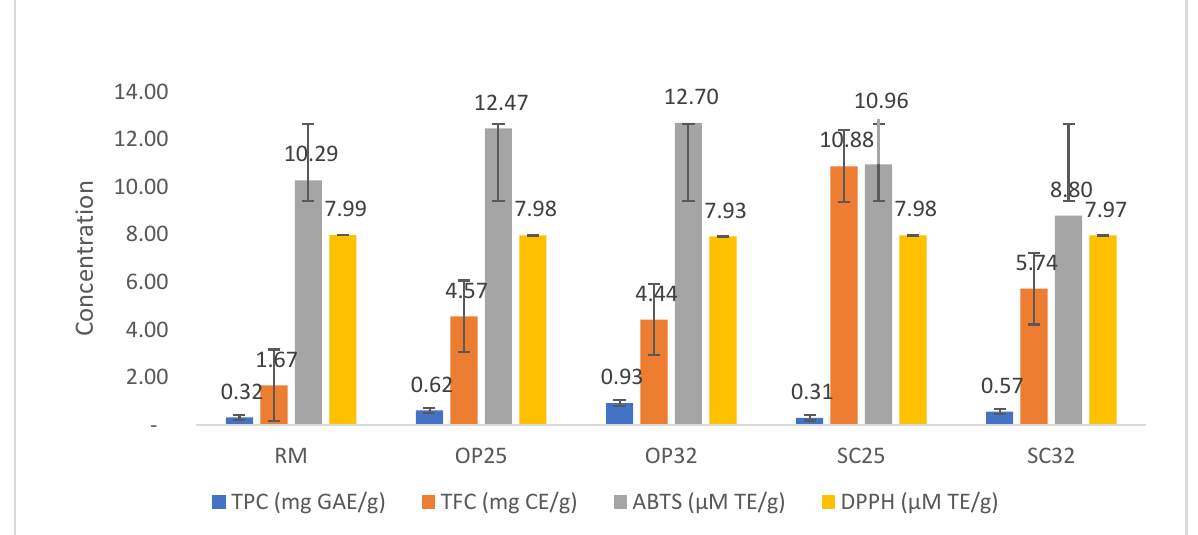
Figure 1. Total phenolic content, total flavonoid content, and antioxidant assay of raw milk and amasi . RM—raw milk, OP25—optimized fermented milk ( amasi ) at 25 °C, OP32—optimized fermented milk ( amasi ) at 32 °C, SC25—fermented milk ( amasi ) with starter culture at 25 °C, SC32—fermented milk ( amasi ) with starter culture at 32 °C. TPC—total phenolic content, TFC—total flavonoid content, ABTS—2,2-Azinobis (3-Ethyl-Benzothiazone-6-Sulphonic acid) (ABTS), DPPH—2,2-diphenyl-1- picrylhydrazyl. Each value is a mean of triplicate